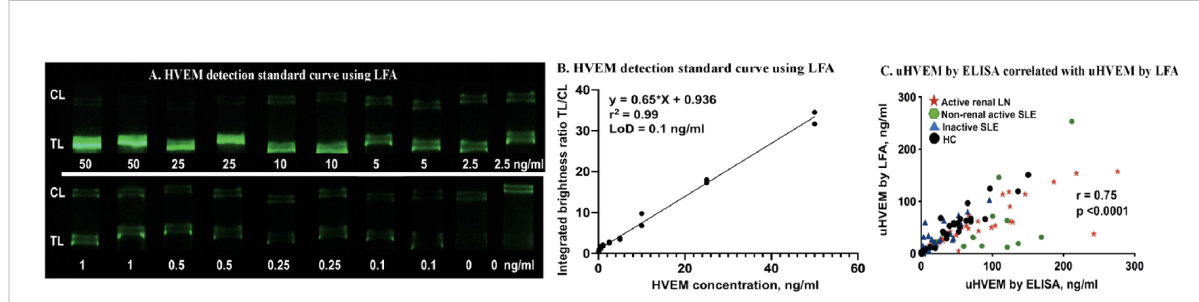
FIGURE 6 uHVEM detection by LFA and ELISA in clinical samples. (A) An HVEM standard curve in buffer was constructed using lyophilized anti-HVEM nanophosphors. (B) The HVEM standard curve LFA strips were imaged using a smartphone, and the correlation of HVEM concentration with TL/ CL ratios is shown. This regression equation was then used to convert the LFA TL/CL ratios observed in the clinical samples to HVEM concentration. (C) Plotted is the Pearson correlation of uHVEM assayed by ELISA versus uHVEM assayed by